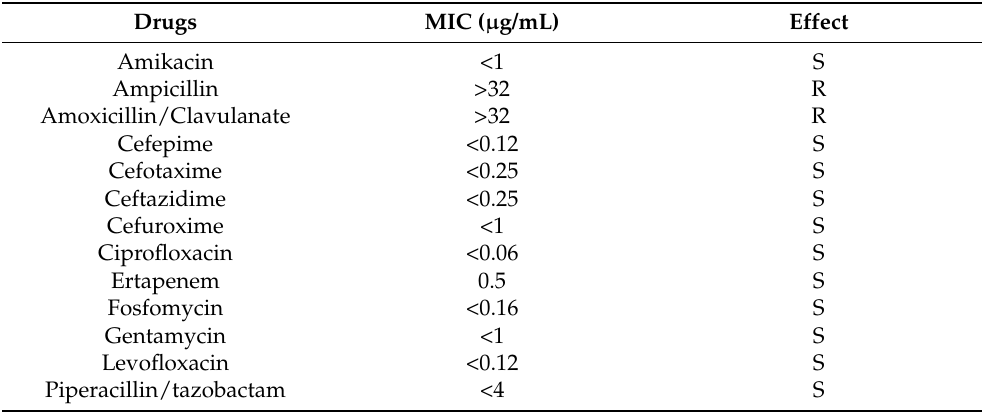
Figure 1. Surgical treatment with fasciotomy in young child. Table 3. Klebsiella species isolated from swab surgical wound of the right lower limb on 04 August 2019. S: sensitive; R: resistant.